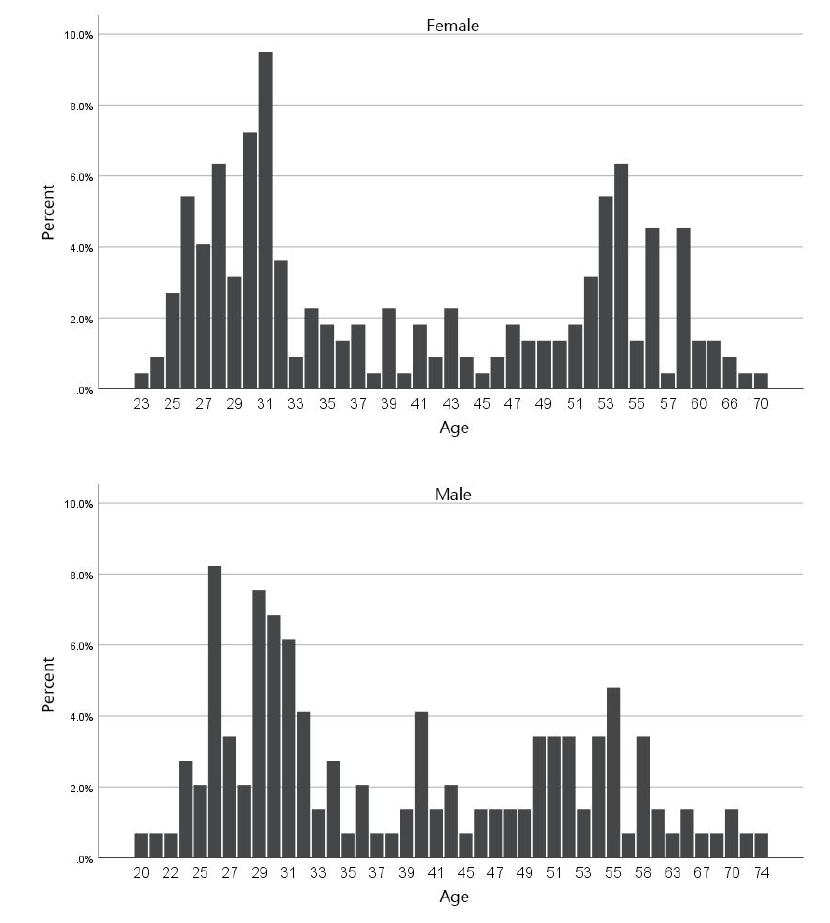
Figure 2. Age and gender distribution of the respondents.